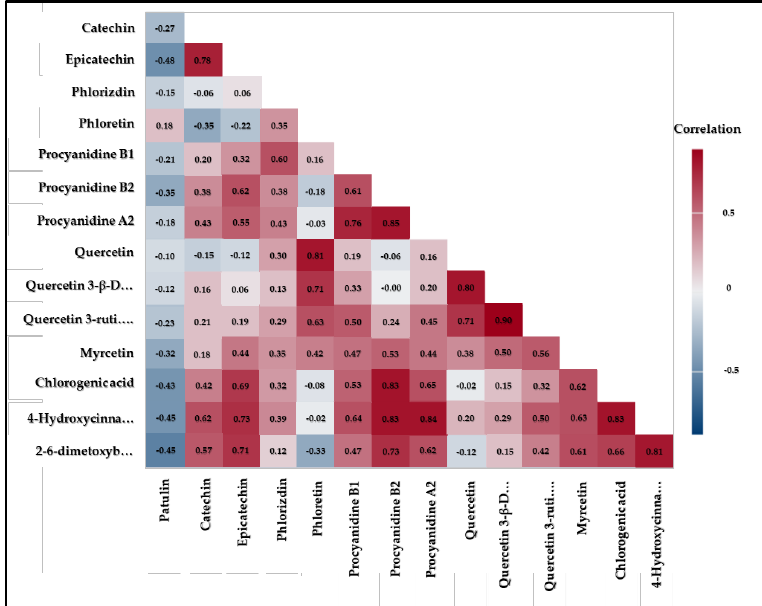
Figure 2. The colour map of correlations of patulin with identified polyphenols.